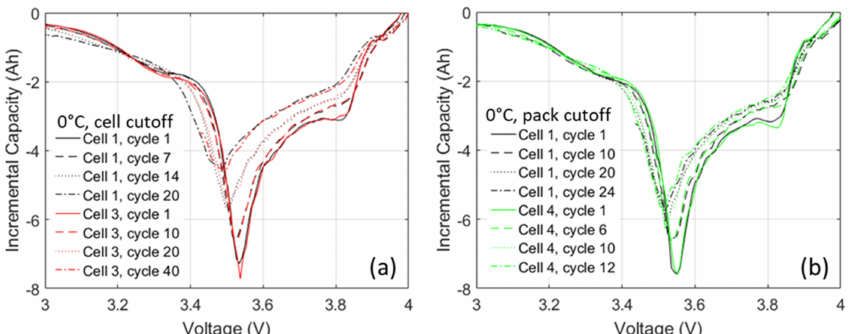
Figure 14. IC curves evolution for selected cycles for ( a ) Cells 1 and 3 for the pack with cell cutoff and ( b ) Cells 1 and 4 for the pack with pack